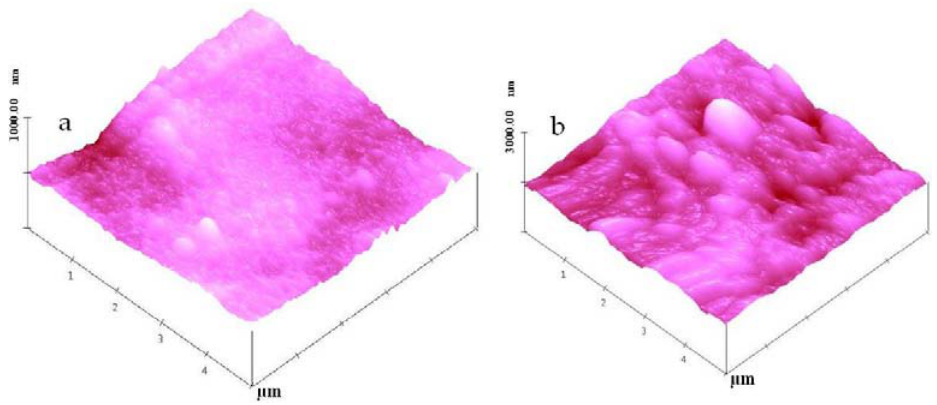
Figure 15. Atomic force microscopy (AFM) graphs from surface of samples ( a ) reference, ( b ) AFD250550.